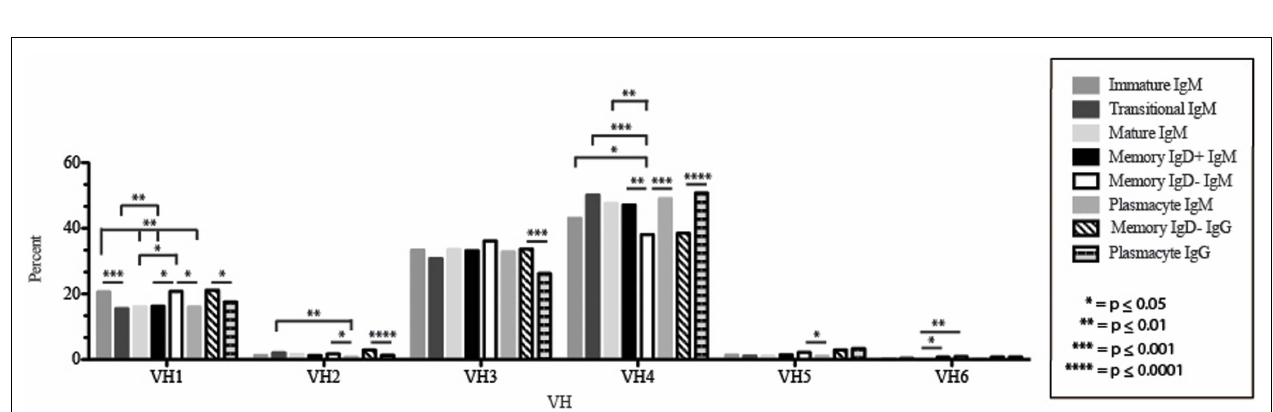
FIGURE 2 | Deconstruction of the contributing components to CDR-H3 length in Ig µ and Ig γ reads containing identifiable D H gene segments as a function of B cell development in the peripheral blood. The contributions of nucleotides provided by theV H , D H , and J H gene segments, by P junctions, and by the extent of N addition at the V H → D H and D H → J H junctions to the CDR-H3 length are illustrated. The IgAT (42) identified the CDR-H3 as amino acids 105–117, according to the IMGT unique numbering system.The average length was